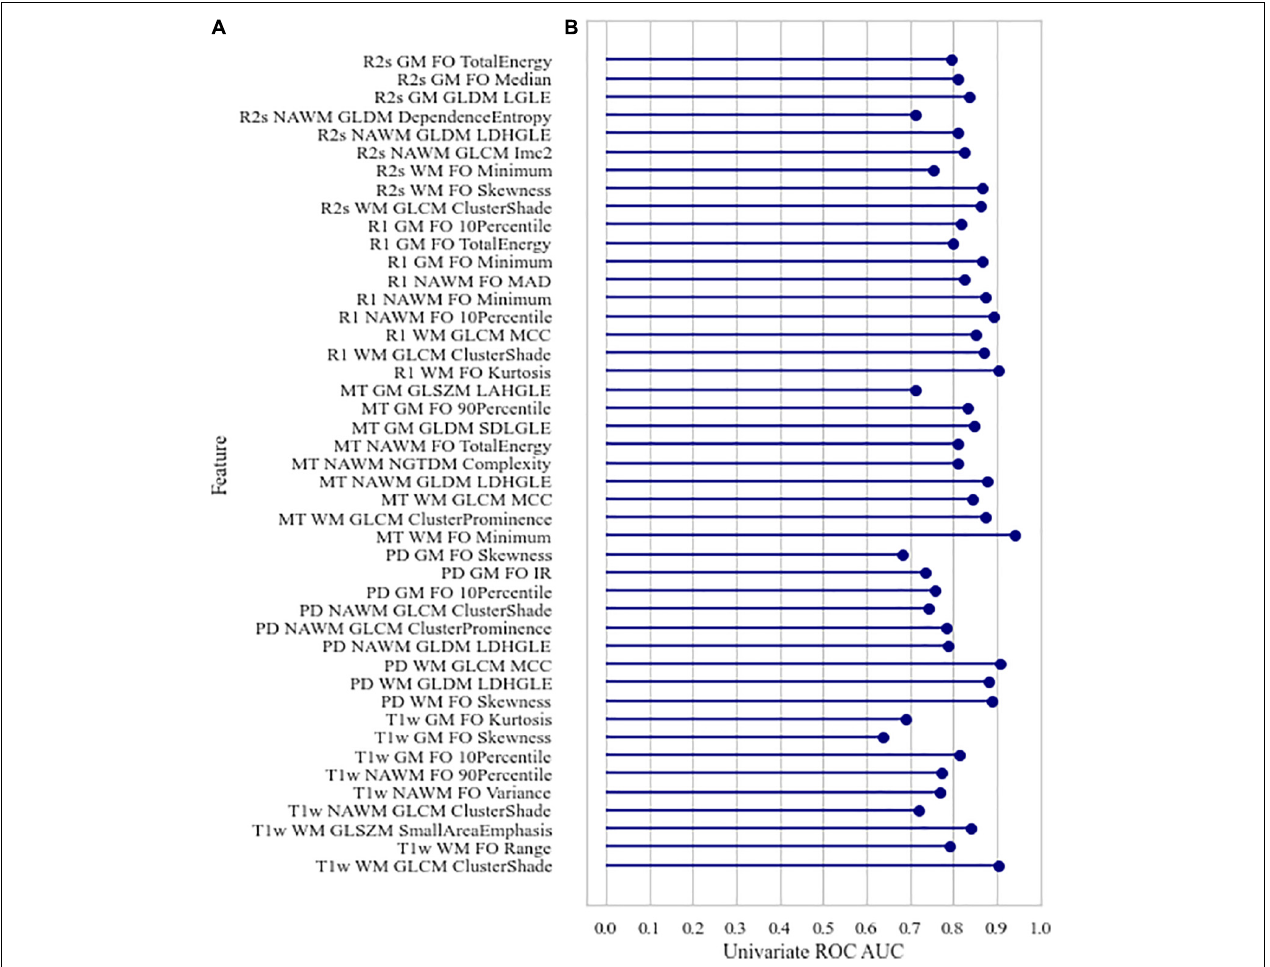
FIGURE 4 | Characteristics of the selected features: (A) Spearman age correlation coefficient (absolute) | r age | and Spearman volume correlation coefficient (absolute) | r volume |, (B) univariate area under the receiver operating characteristic curve, corrected p -values of Mann–Whitney test for differences in value distribution in classes. FO, first order; LDHGLE, large dependence high gray level emphasis; SDLGLE, small dependence low gray level emphasis; LAHGLE, large area high gray level emphasis; MAD, mean absolute deviation; LGLE, low gray level